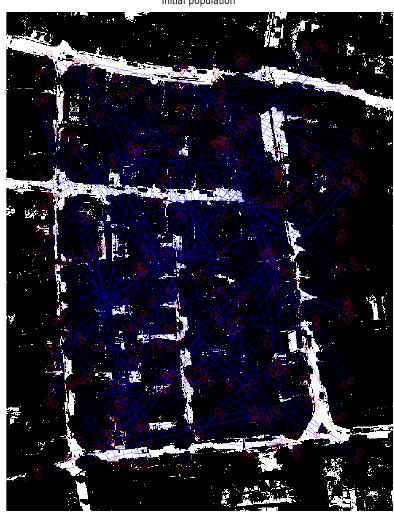
Figure 5. Initial population on the segmented image During the computation the fitness of all genes are calculated, then a cumulated fitness are derived, which is excellent to describe the population. The average running time for training is between 1300 and 3600 s.